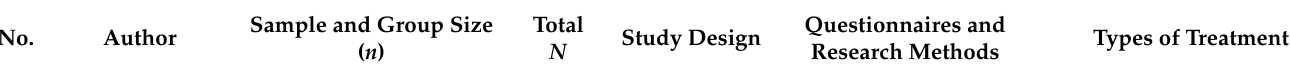
Table 2. Summary of publications included in the systematic review which met the eligibility